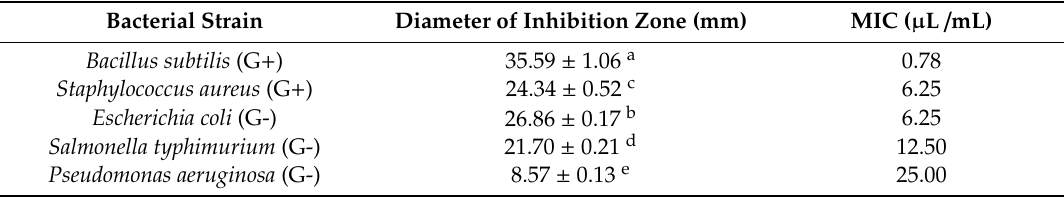
Table 2. The antimicrobial activity of grapefruit light phase essential oil (LPEO). Bacterial